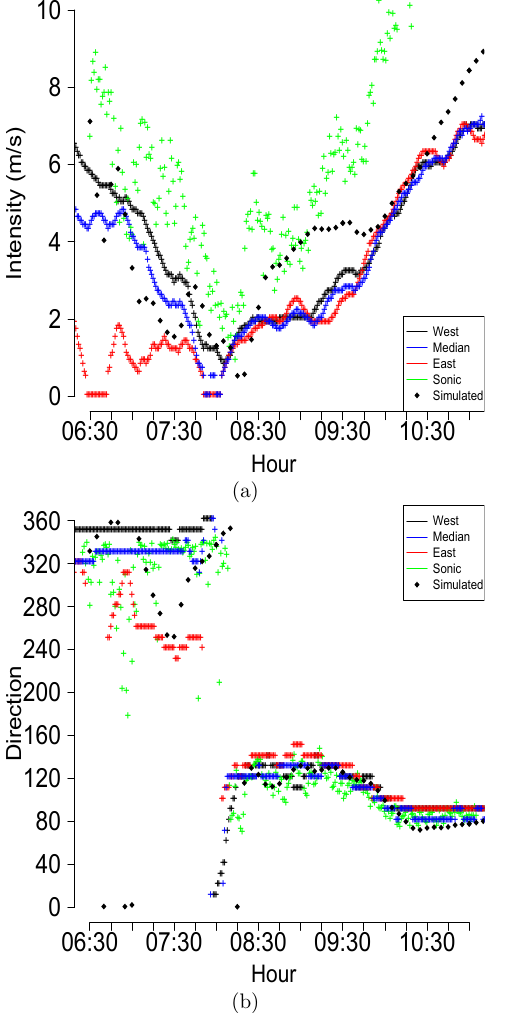
Fig. 9. Wind intensity (a) and wind direction (b) observed (colored +) by the four anemometers installed on the runways during the LIDAR2009 experiment and simulated (black dots) over the Nice airport for the 27 March 2009.